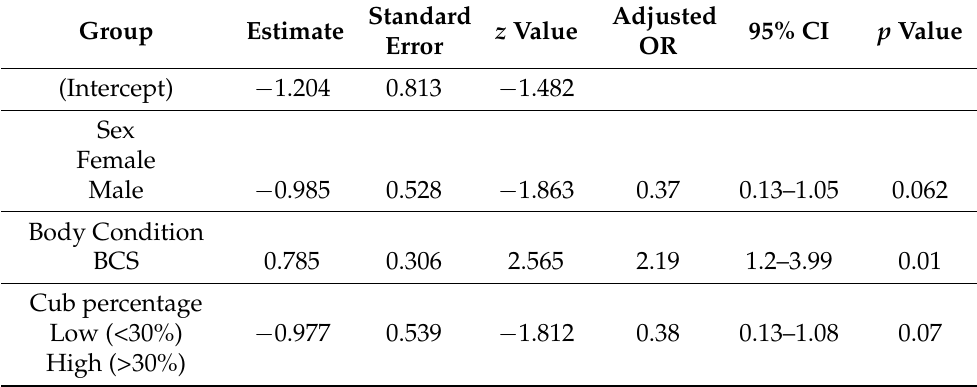
Table 3. Final general mixed effect model of multivariable logistic regression analysis for juveniles.